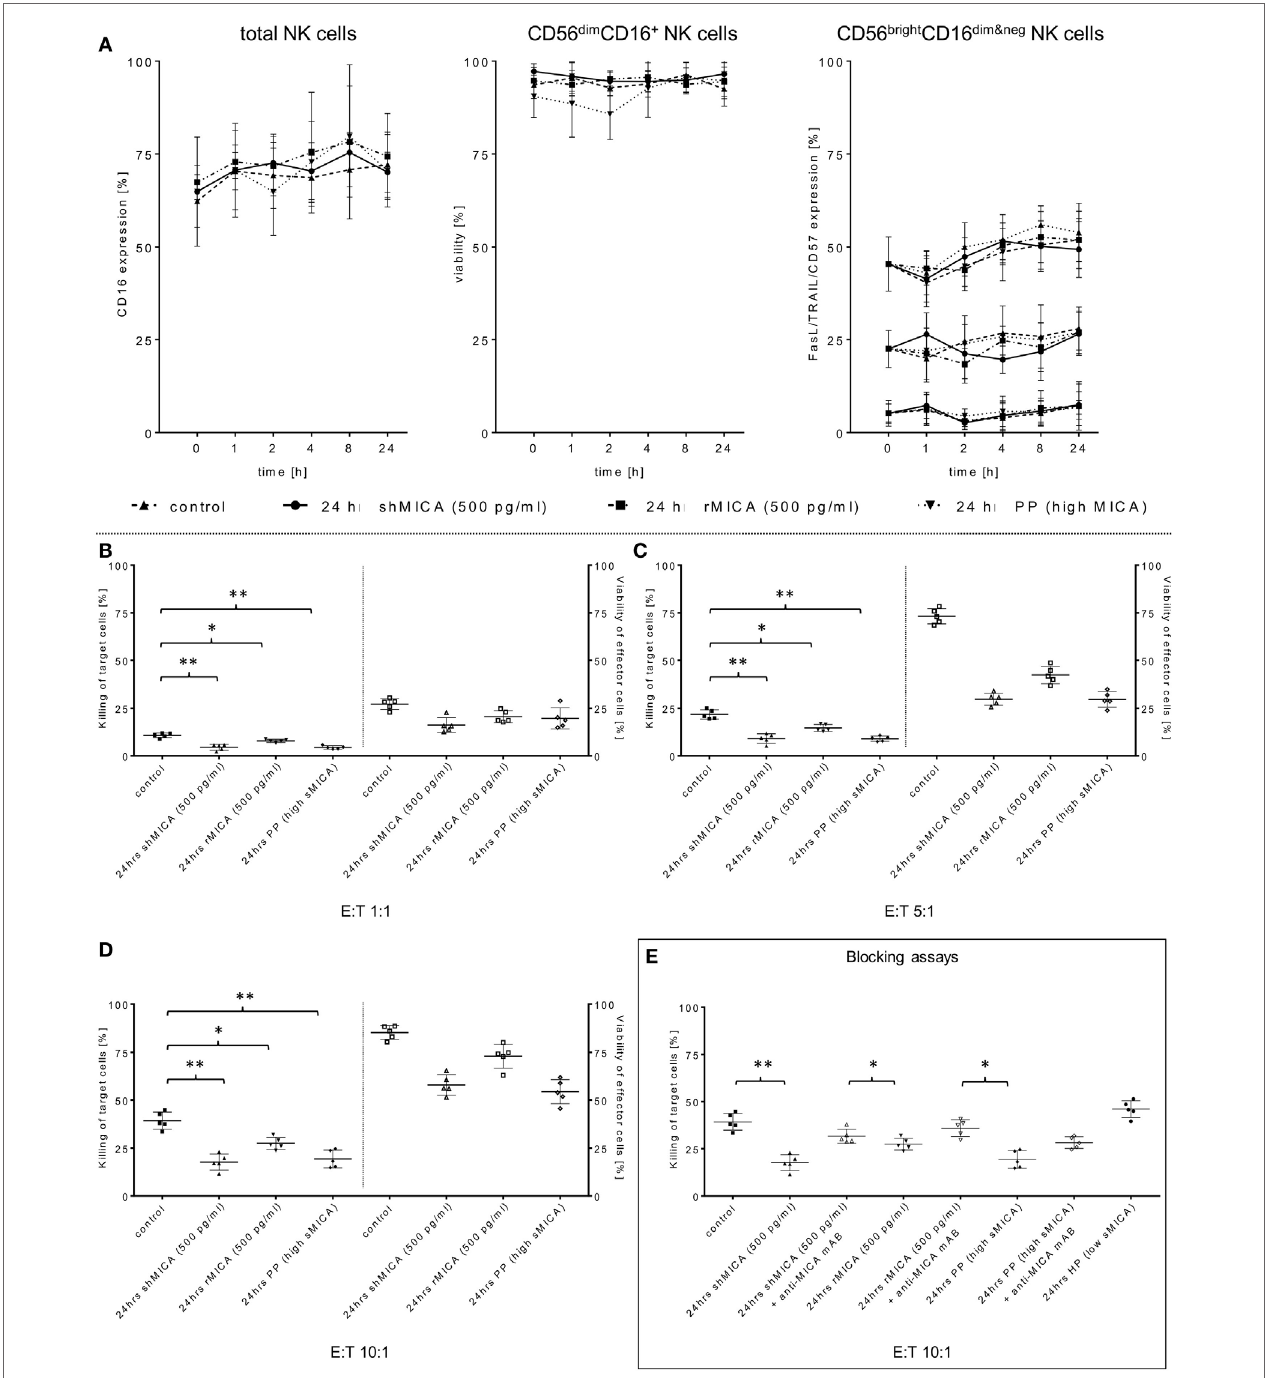
FigUre 3 | Determination of the sMica impact on aDcc-stimulating and pro-apoptotic nK cell receptors . (a) Surface expression levels of CD16, TRAIL, FasL, and CD57 on the same effector cell samples were measured at the indicated time points and compared to non-treated control cells. As an additional control, effector cell viability was monitored over a 24-h period (B–D) . The impact of sMICA on the NKG2D-mediated NK cell cytotoxicity and NK cell stability during effector-target interactions against primary HNSCC cells ( n = 5) was analyzed by FCM. Therefore, the same overnight-treated NK cell samples (see above, section Figure 2a ) were subsequently co-incubated for 4 h (37°C, 5% CO 2 ) with corresponding patient HNSCC target cells at the indicated E:T ratios. (e) Inhibition of sMICA effects on NKG2D-mediated NK cell cytotoxicity. SMICA molecules in all treatment samples (shMICA, rMICA, and PP) were blocked by pre-incubation (20 min) with MICA-specific mABs (20 μ g/ml, MAB13001). NKG2D-dependent killing rates of those incubated NK cells against primary HNSCC cells were measured after 4 h (“Blocking assays,” ratio: 10:1, 37°C, 5% CO 2 ) as described above. Data are shown as mean ± SD from three to four experiments for each patient. Statistically significant difference: * p ≤ 0.01 and ** p ≤